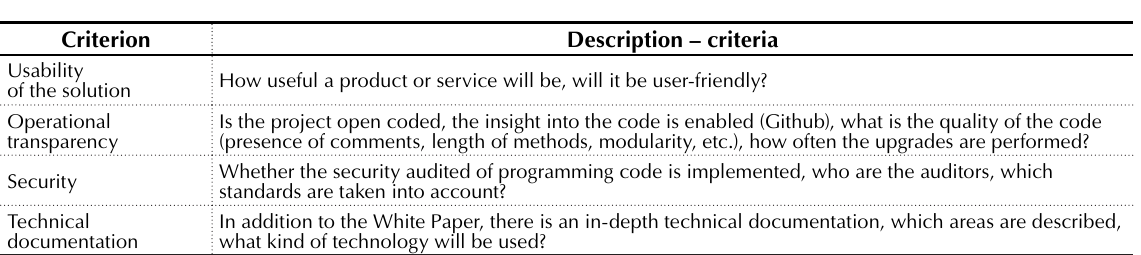
Table 4. Dimension “The product”